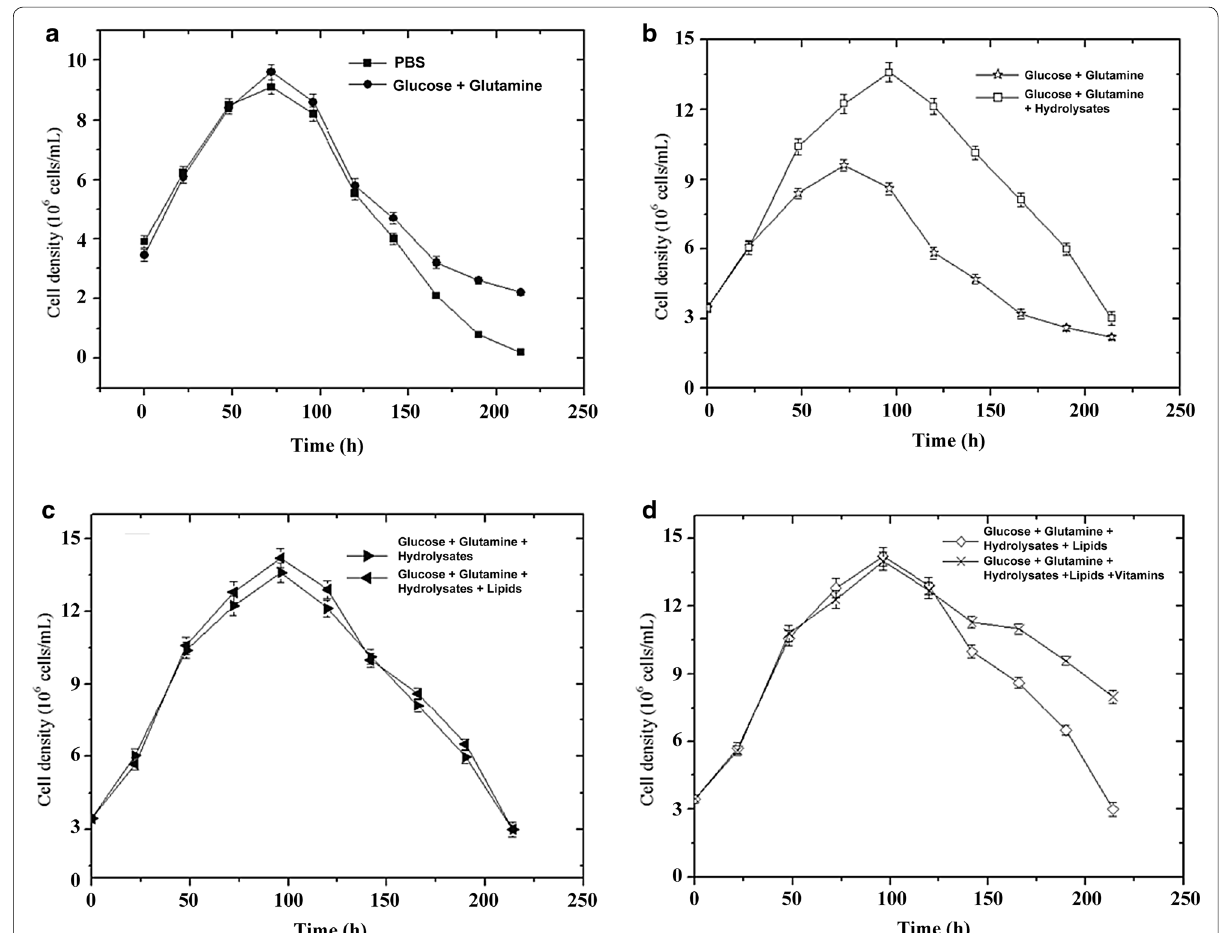
Fig. 2 Effects of glucose, glutamine, hydrolysated, lipids and vitamins on the cell growth viability maintenance. a Compared the cells fed with PBS and glucose glutamine only, b compared the cells fed with glucose glutamine and glucose glutamine hydrolysates, c compared + + + + with the cells fed with glucose glutamine hydrolysates and glucose glutamine hydrolysates lipids, d compared with the cells fed with + + + + + glucose glutamine hydrolysates lipids and glucose glutamine hydrolysates lipids + + + + + + +